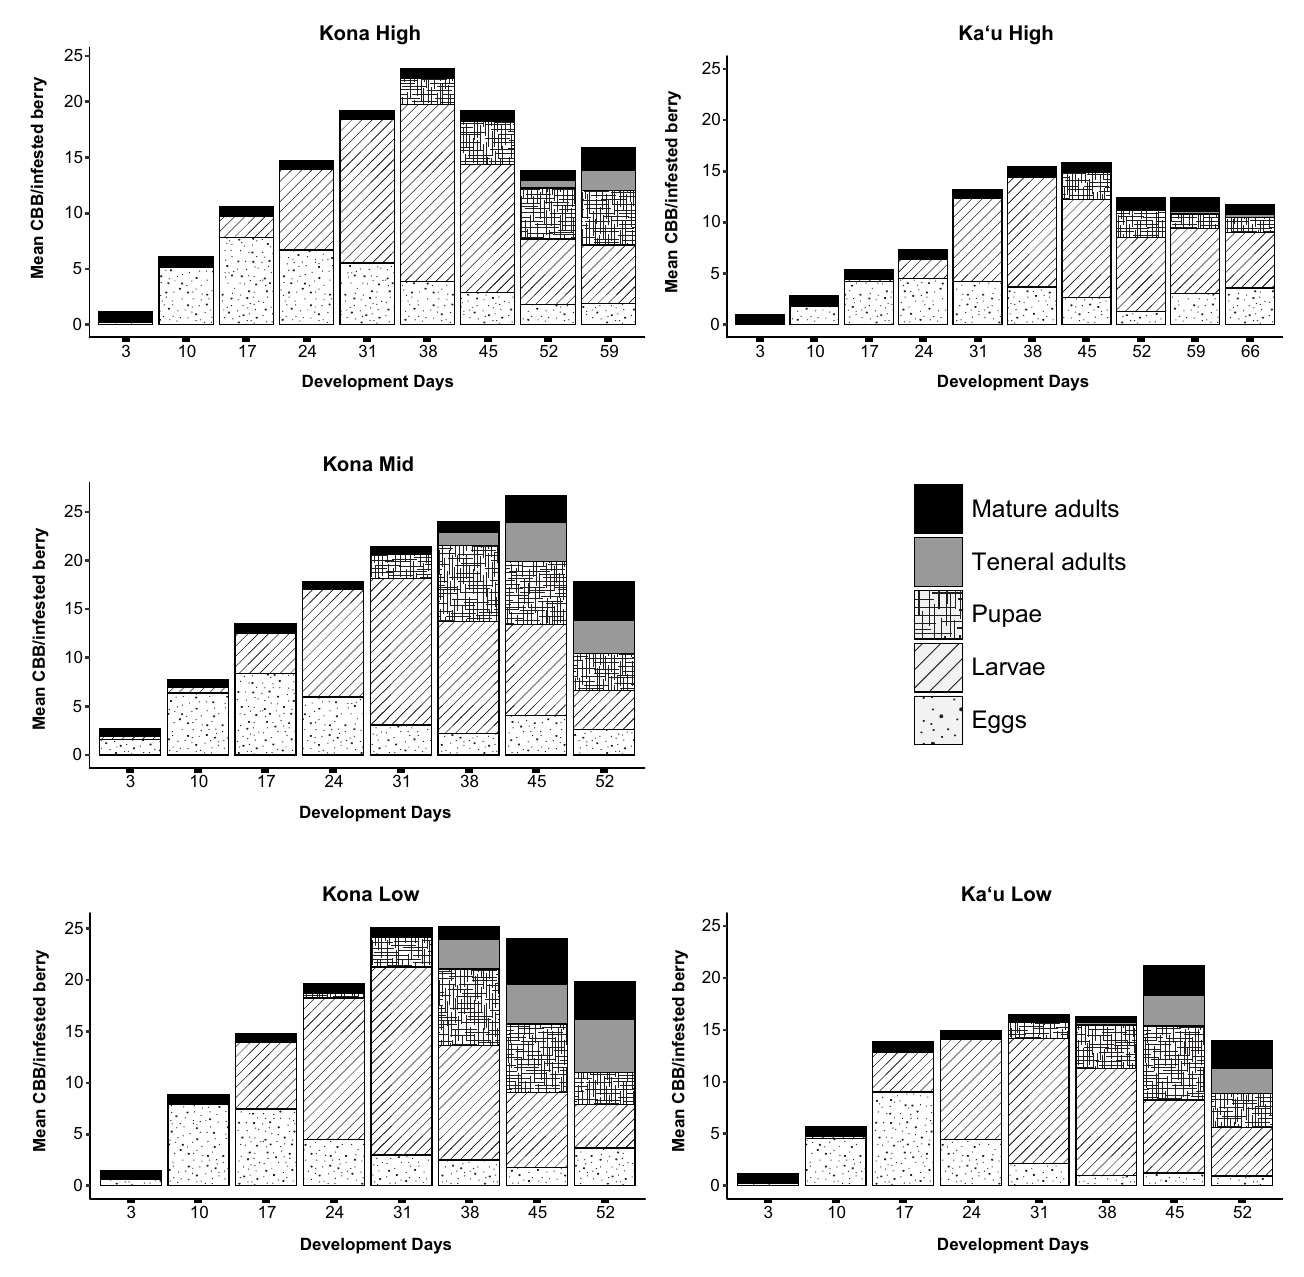
Fig 2. Mean numbers of each CBB life stage documented from dissections of infested coffee berries. Estimated infestation dates ranged from September 8–15 2017, and berry collections occurred on a weekly basis until November 1–15, 2017.